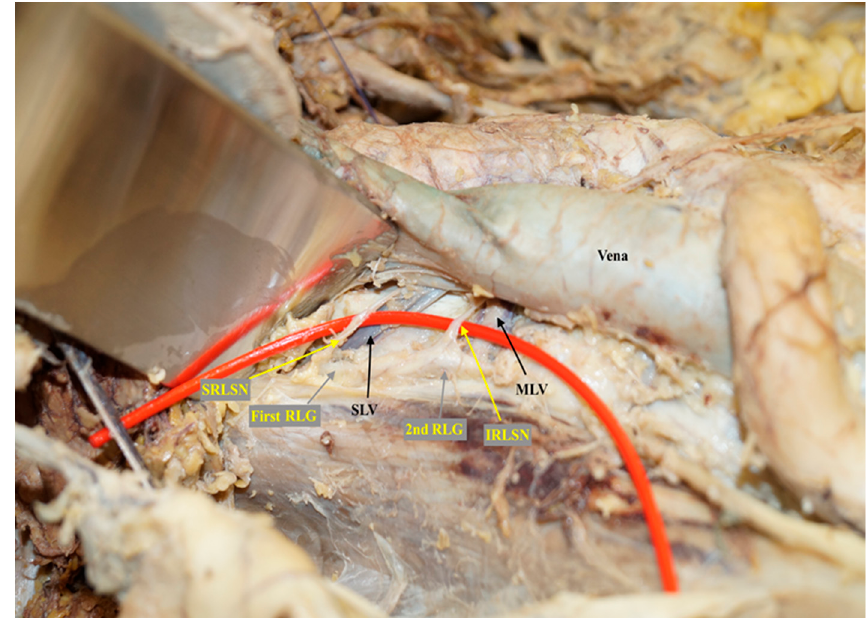
Figure 2. The emerging of superior and inferior lumbar splanchnic nerves in the first and second lumbar ganglions directly at the level of superior and middle lumbar veins in one cadaver preparation for this study. SRLSN, superior right lumbar splanchnic nerve; SLV, superior lumbar vein; 1st RLG, first right lumbar ganglion of sympathetic trunk; IRLSN, inferior right lumbar splanchnic nerve; MLV, middle lumbar vein; 2nd RLG, second right lumbar ganglion of sympathetic trunk.